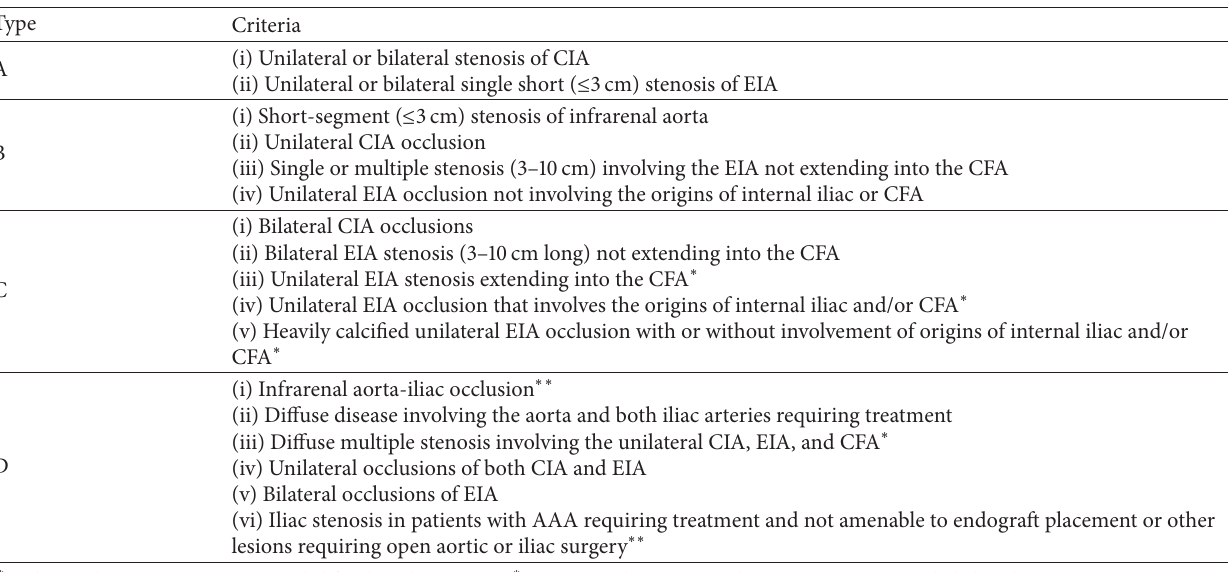
Table 2: TASC II classification of aorta-iliac lesions.